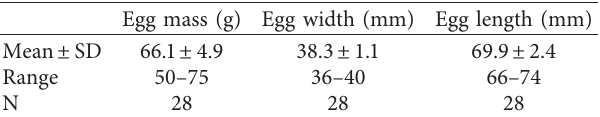
Table 6: Clutch attributes of West African dwarf crocodile in Chirehin Community Land (2017). SD and N represent standard deviations and the total number of recordings used for the cal- culations,